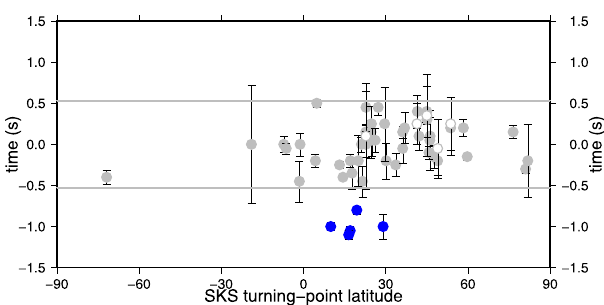
Fig. 2 Double differential travel times from earthquake pairs. The smallest differential arrival time change between SKS and reference phases Pdiff, Sdiff, PP, or SS, δ t SKS − δ t X (X: Pdiff, Sdiff, PP, SS) is plotted as a function of the SKS wave turning point latitude. Measurement error bars are determined based on a varying time window analysis. For the COLA seismograms in Fig. 1, the value of the smallest relative time change is δ t − δ t = − 1.05 s, and the turning point latitude is 17.08 ∘ N. The gray SKS Sdiff open circles are measurements from two earthquakes that are less than 10 years apart in time. The 1.5 standard deviation of δ t SKS − δ t X of the dataset is 0.53 s, and it is plotted for reference only. The fi ve anomalous SKS travel times that can not be explained by earthquake mislocations based on hypocenter grid search (Methods) are plotted in blue circles. Except for the SKS waves recorded at station CCM which has a turning point latitude of 29.05 ∘ N, the other four anomalous SKS waves are from the same earthquake pair with turning point latitudes at 9.96 ∘ N (ULN), 16.51 ∘ N (YAK), 17.08 ∘ N (COLA), and 19.46 ∘ N (INK). The smallest relative arrival time change does not carry signi fi cance in analysis but for illustration purposes